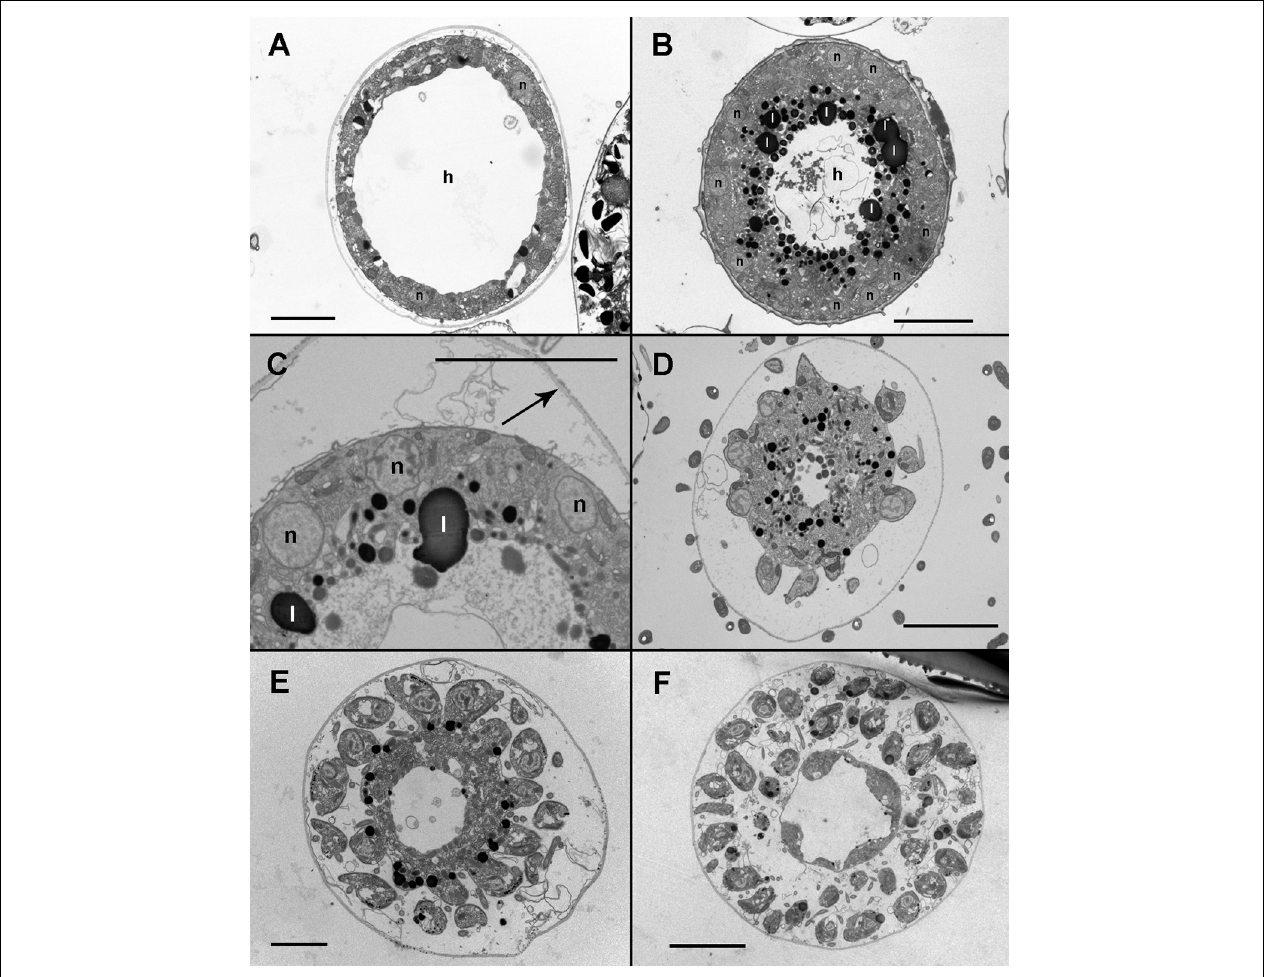
FIGURE 5 | Transmission electron microscopy (TEM) micrographs of Maranthos nigrum showing the parasitoid’s life-cycle stages from early sporont to sporangium during infection of Alexandrium minutum . (A) Karyokinesis in an early sporont. The cytoplasm is restricted to the cell periphery and the central area is occupied by hyaline material. (B) A sporont with multiple nuclei. The inner cytoplasm is occupied by lipid droplets and the central area is made up of hyaline material. (C) Detail of the cytoplasm; several organelles are visible. Note that the external wall (arrow) is detached from the cell body. (D) Late sporont with zoospores beginning to form in the cell periphery. (E) Late sporont containing both already formed zoospores and zoospores still attached to the central body. (F) Sporangium showing mature zoospores detached from the central body, which has been almost completely consumed. Abbreviations: h = Hyaline material; l = lipid granule; n = nucleus. All scale bars = 5 µ m, except (A,E) = 2 µ m.